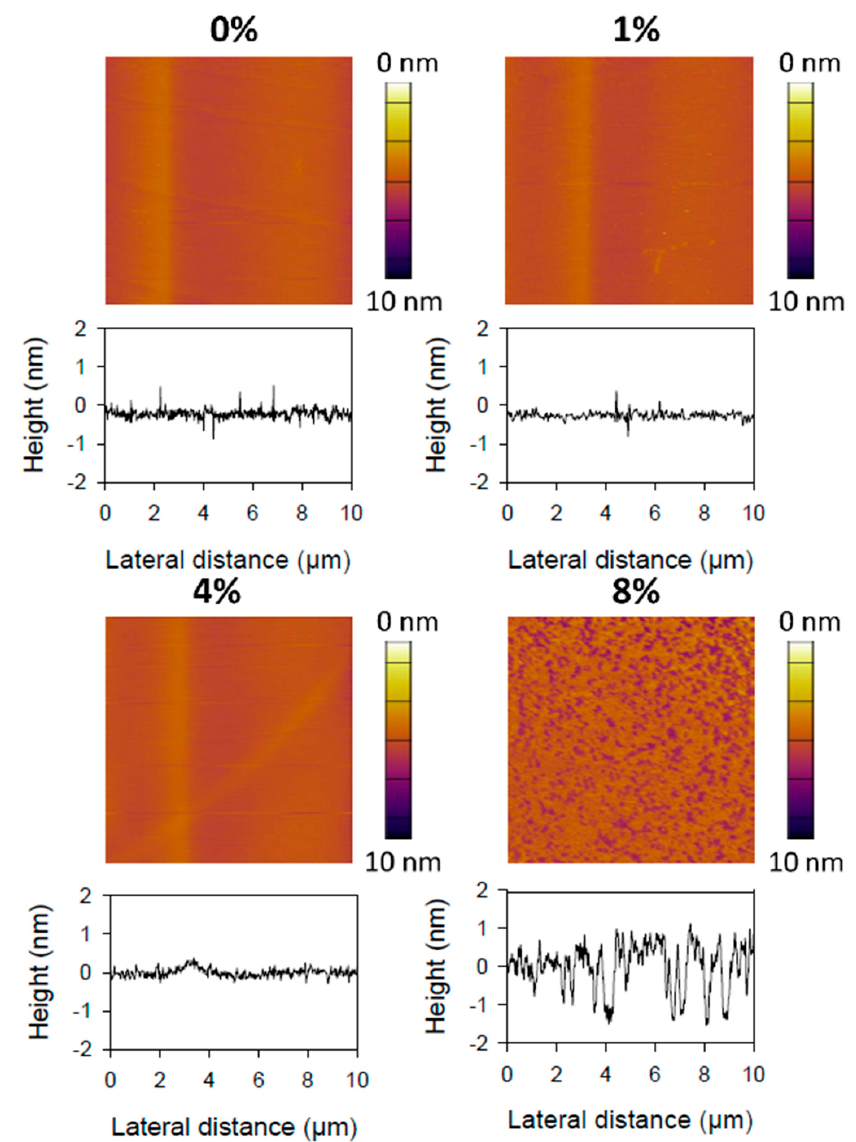
Figure 8. Atomic force microscopy (AFM) topography of DOPC bilayer containing 0, 1, 4, or 8 mol% of curcumin. Lateral friction forces damaged the sample at 12 mol% of curcumin.